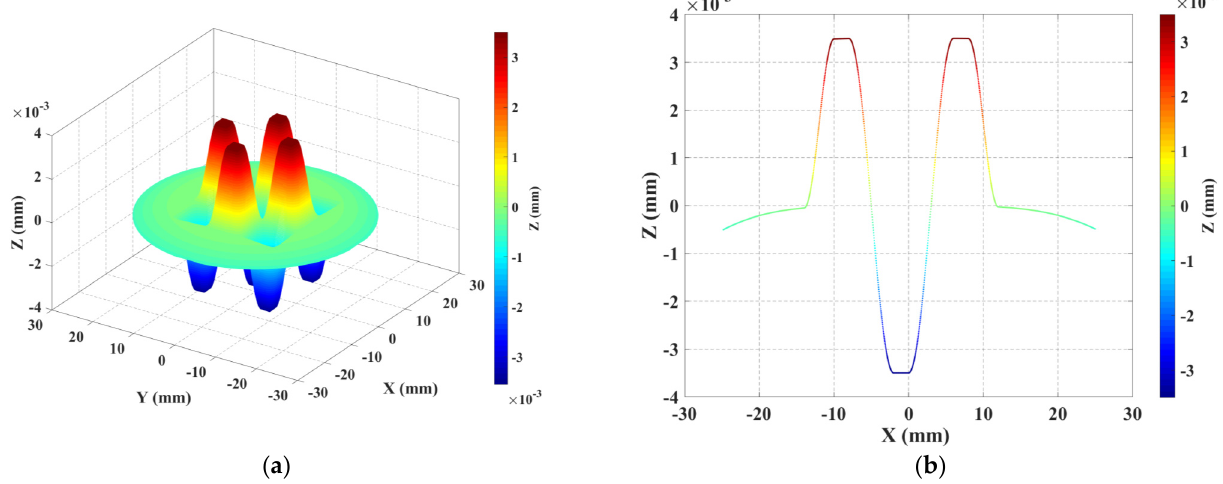
Figure 5. ( a ) Design of the thermo-invariant material measure for aspherical surface (TIMM-1), ( b ) bottom: y = 0 plane. The nominal shape is contained inside two similar aspherical shapes forming the artificial envelope, which represent the form error. Table 1. Nominal shape parameters for